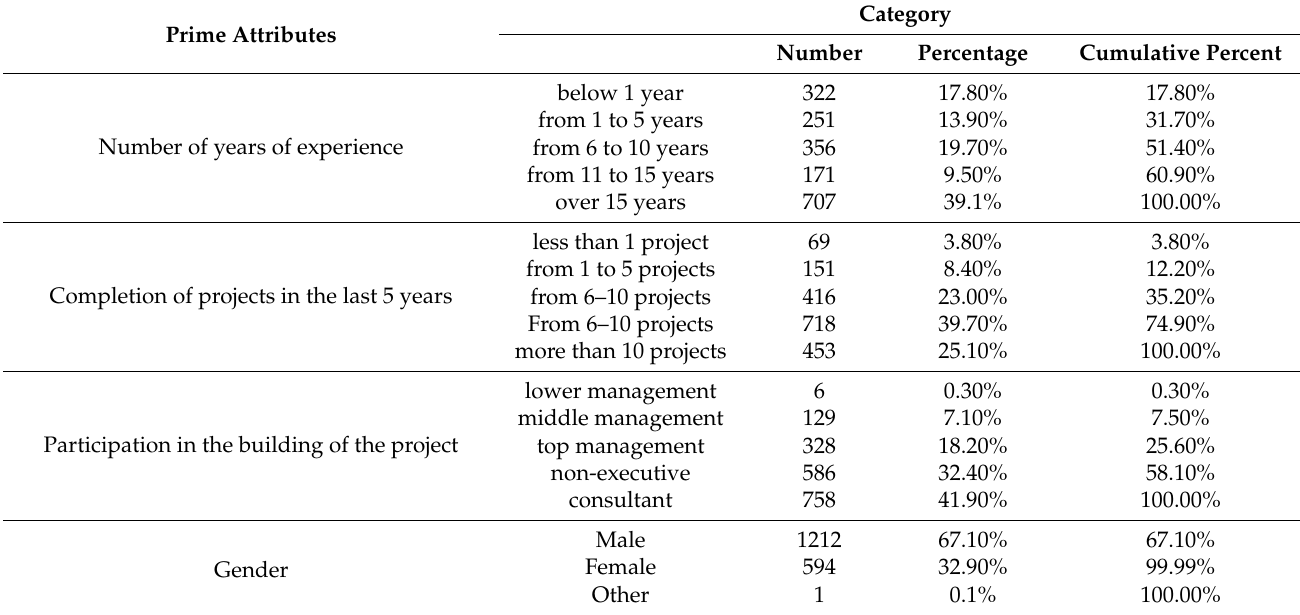
Table 2. Experts’ demographics and professional backgrounds in the